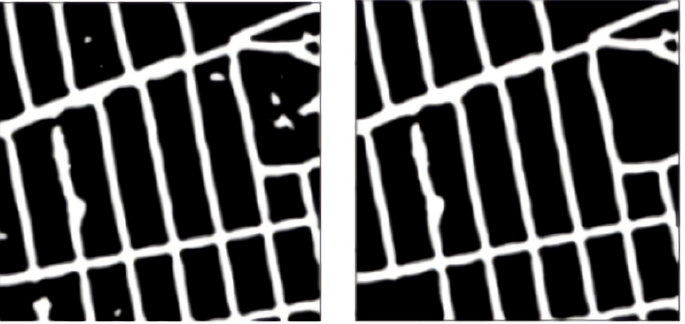
Figure 9. Connected small blob removal. The left side is the original image and blob cleaned output.